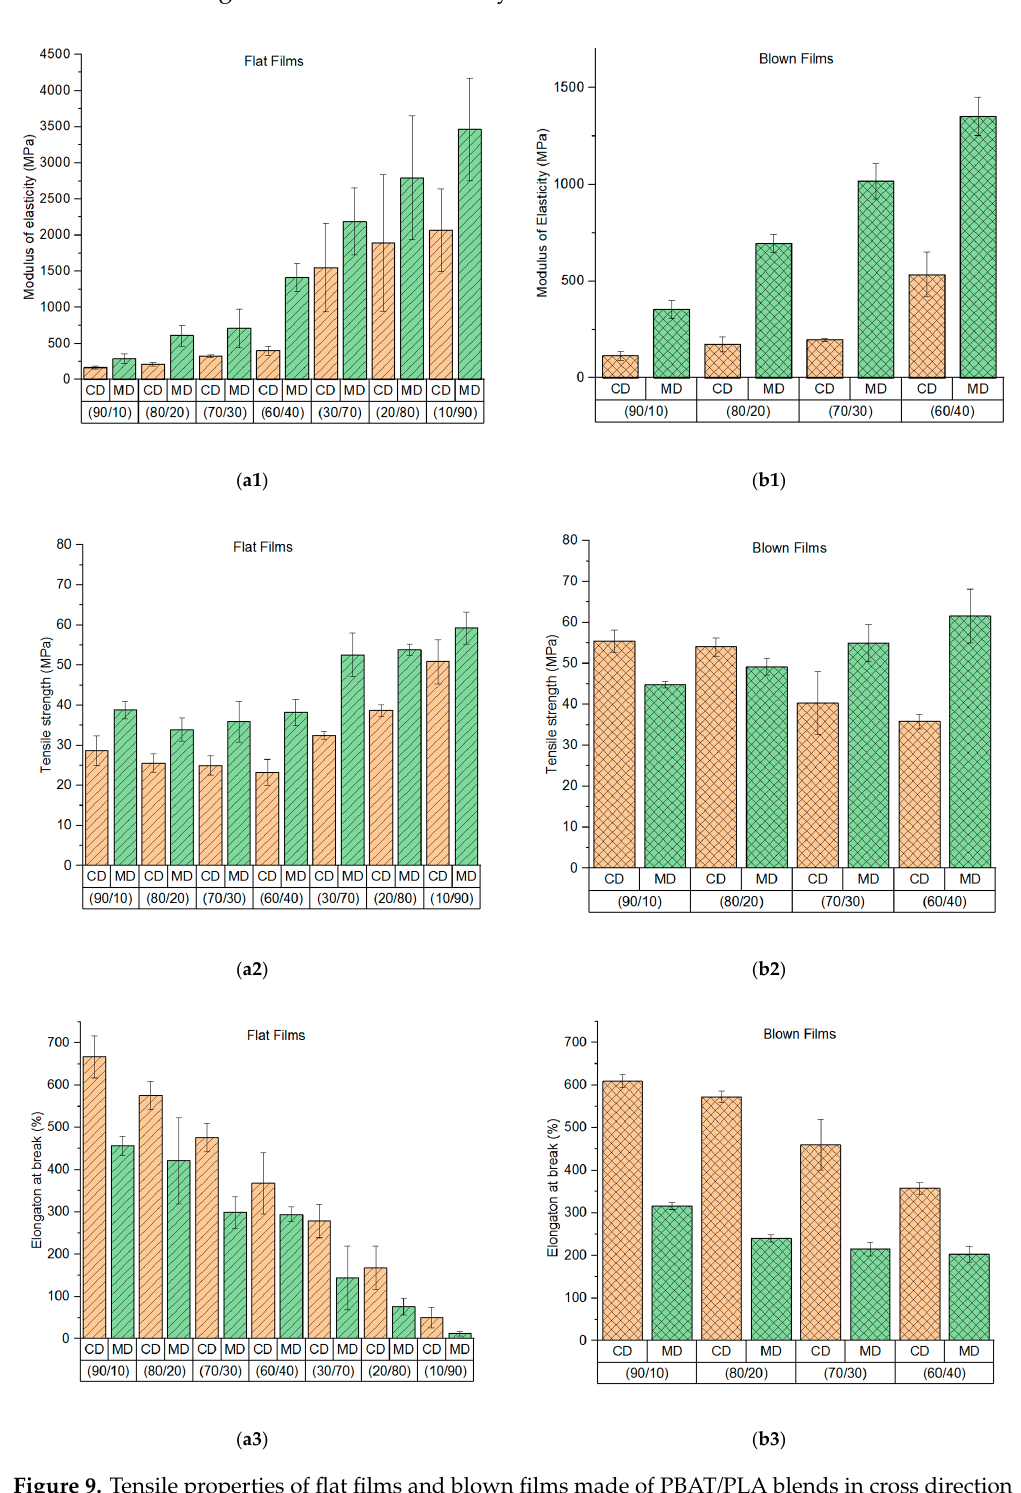
Figure 9. Tensile properties of flat films and blown films made of PBAT / PLA blends in cross direction (CD) and machine direction (MD): ( a1 ) modulus of elasticity of flat films, ( b1 ) modulus of elasticity of blown films, ( a2 ) tensile strength of flat films, ( b2 ) tensile strength of blown films, ( a3 ) elongation at break of flat films, ( b3 ) elongation at break of blown